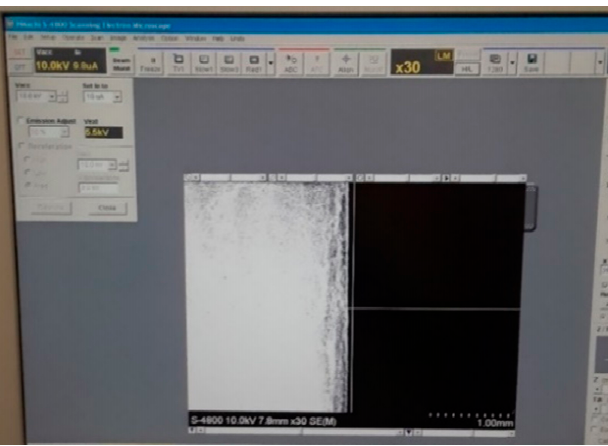
Figure 17. The fiber direction side of mat is in coincidence with the vertical axis of the SEM device.